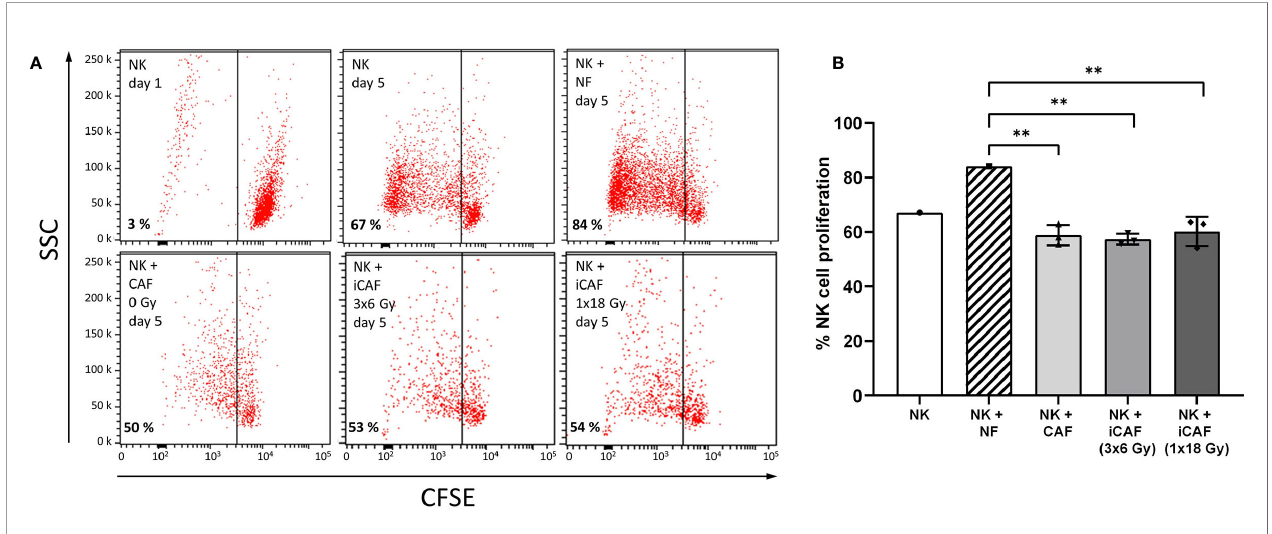
FIGURE 3 | Effects of cancer-associated fi broblasts (CAFs) on natural killer (NK) cell proliferation. (A) Representative fl ow cytometry dot plots of the different experimental groups, showing percentage of carboxy- fl uorescein succinimidyl ester (CSFE)-labeled NK cells on a side-scatter axis. (B) Bars representing mean (± SD) values for NK cell proliferation obtained from experiments with three different CAF donors. NK cells/NFs co-cultures were used as positive control, and the three experimental groups of NK cells/CAFs co-cultures were compared with the normal fi broblast (NF) group. Statistical P -values between NFs and CAFs co-cultures were determined using one-way ANOVA with Tukey correction for multiple comparisons. ** indicates P <